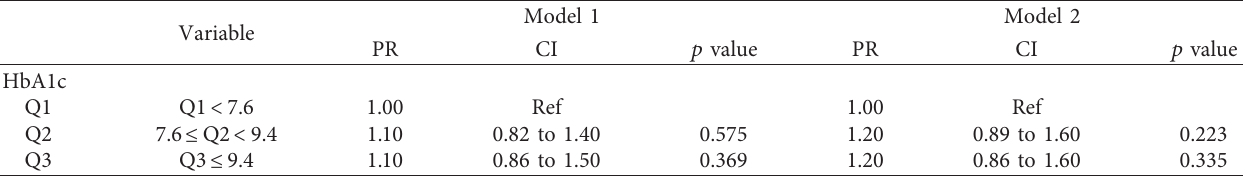
Table 2: Prevalence ratio of atherosclerosis based on Cox regression on each tertile of HbA1c levels. Model 1 Model Variable